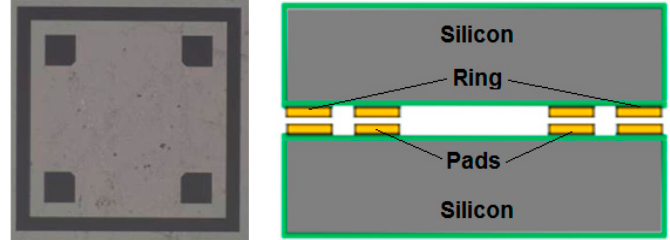
Figure 1. Optical view of upper silicon die on the ( left ) and cross sectional drawing on the ( right ) for bond strength test structure.